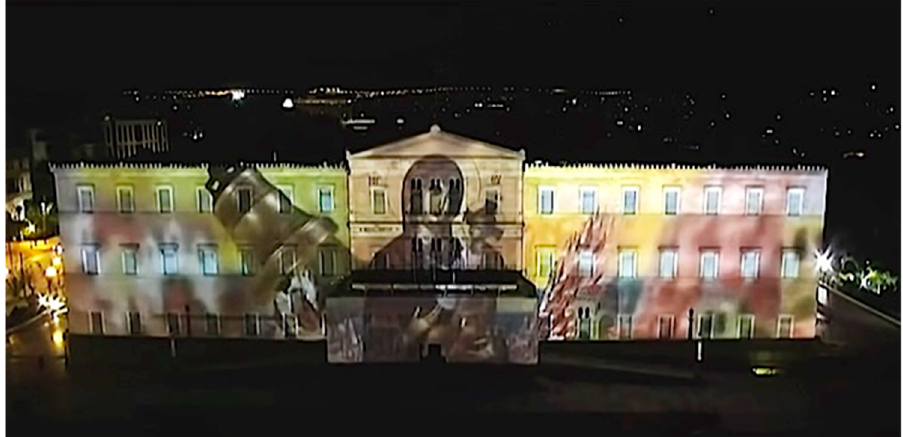
Figure 1. Screenshot by the author from https://www.youtube.com/watch?v=7epqgNstg9o (accessed on 2 October 2021).